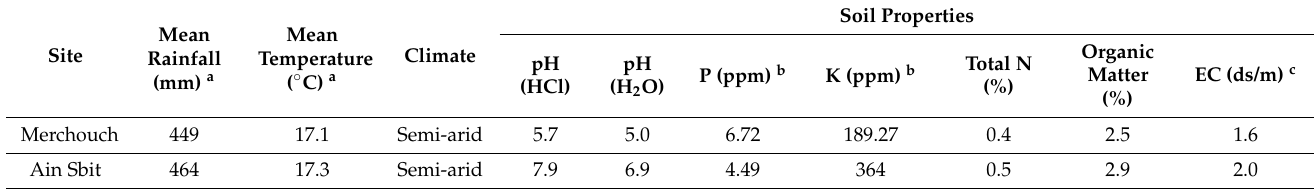
Table 2. Soil properties of experimental